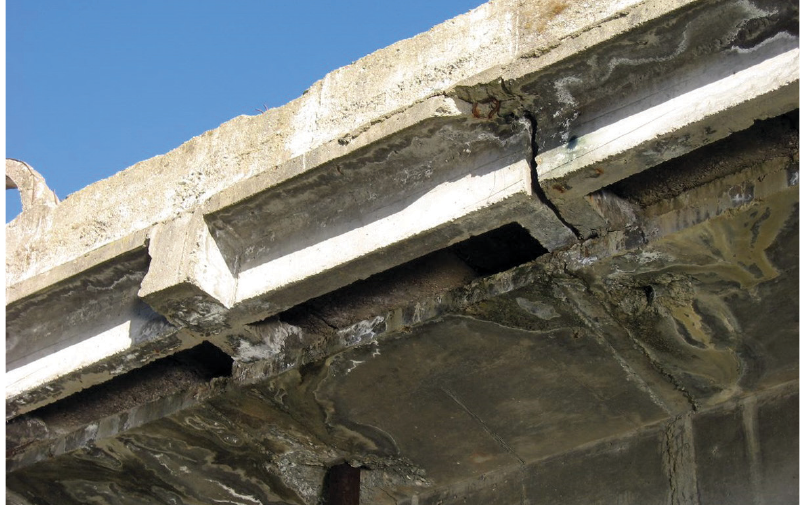
Figure 6. Rating of bridge distress (Chemical attack)